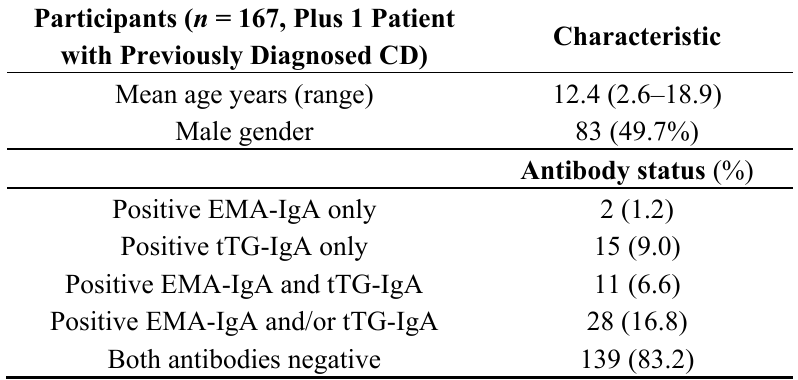
Both antibodies negative 139 (83.2) (CD = celiac disease; EMA = antibody to endomysium, tTG = antibody to tissue transglutaminase; IgA = immunoglobulin A).